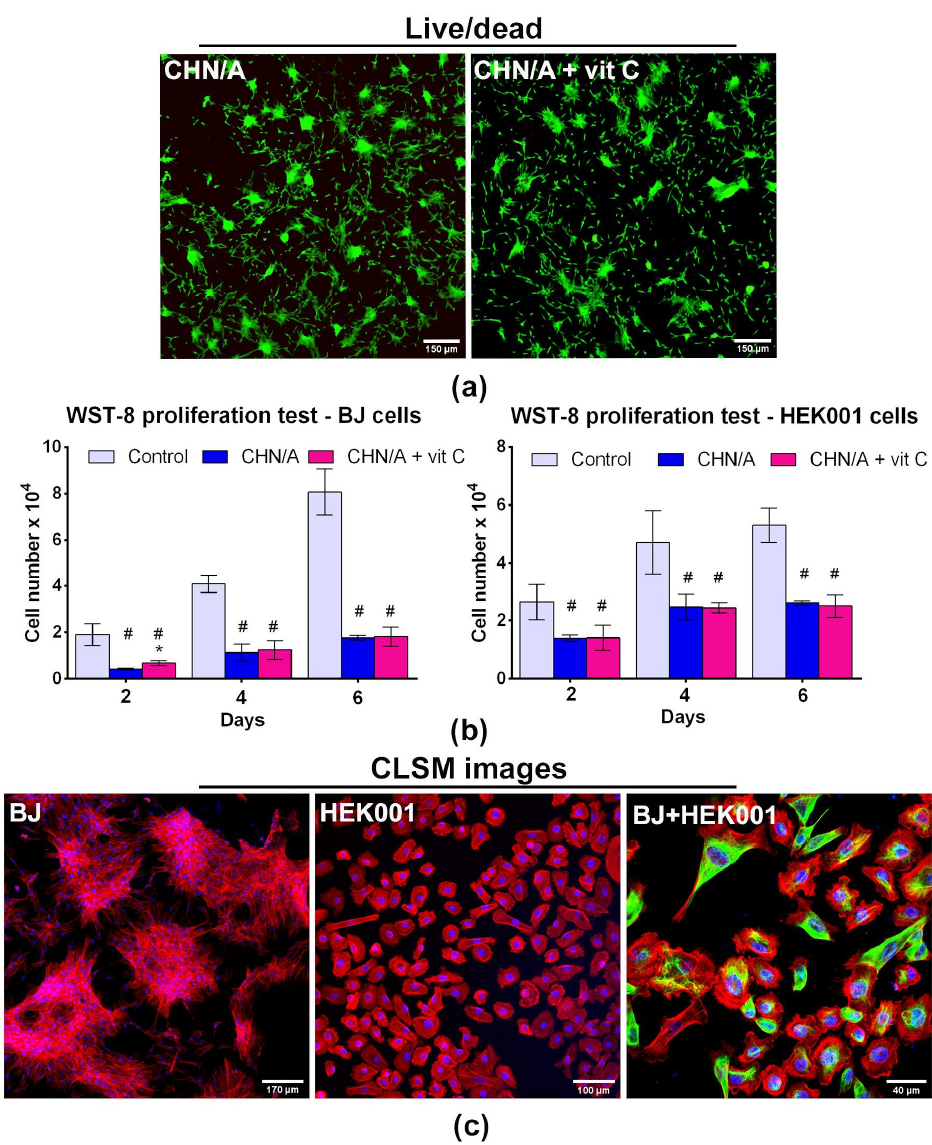
Figure 3. Biocompatibility of the films assessed with the use of human skin fibroblasts (BJ cell line) and human epidermal keratinocytes (HEK001 cell line): ( a ) cytotoxicity evaluation by live/dead staining of BJ cells cultured on the produced films for 48 h (viable cells emit green fluorescence, dead cells give red fluorescence); ( b ) BJ and HEK001 proliferation on the surface of the films assessed by colorimetric WST-8 test (control—cells cultured on the glass coverslip, * statistically significant results compared to CHN/A sample, # statistically significant results compared to the control cells; n = 5 (five independent samples were tested), p value < 0.05, one-way ANOVA followed by Tukey’s test); ( c ) BJ and HEK001 growth on the surface of CHN/A film visualized upon 6-day culture by fluorescent staining of nuclei (blue fluorescence) and actin filaments (red fluorescence); co-culture (BJ + HEK001) was additionally stained by immunofluorescence using anti-vimentin antibodies (green